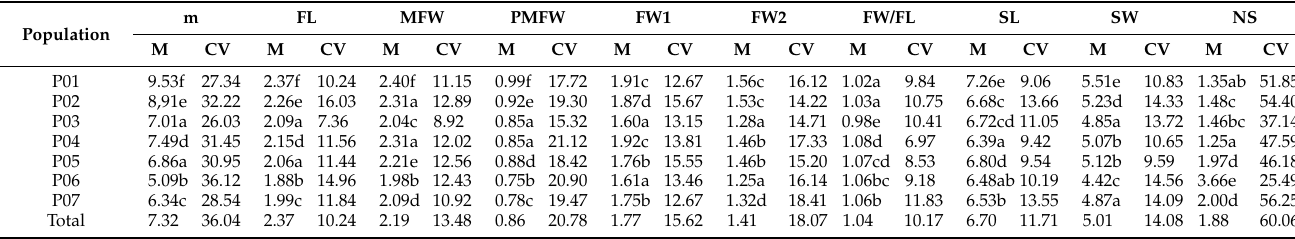
Table 1. Arithmetic means (M) and coefficient of variations (CV/%) for fruit and seed morphometric characteristics. Different letters within one column denote statistically significant differences ( p < 0.05) by Fisher’s LSD test. Acronyms of populations: P01—Psunj; P02—Tounj; P03—Istria; P04—Novi Vinodolski; P05—Split; P06—Braˇc; P07—Konavle. Fruit and seed morphometric characteristics: m (g)—fruit mass; FL (cm)—fruit length; MFW (cm)—maximum fruit width; PMFW (cm)—fruit length, measured from the fruit base to the point of maximum fruit width; FW1 (cm)—fruit width at 15% of fruit length; FW2 (cm)—fruit width at 85% of fruit length; FW/FL—maximum fruit width/fruit length; SL (mm)—seed length; SW (mm)—maximum seed width; NS—number of seeds per